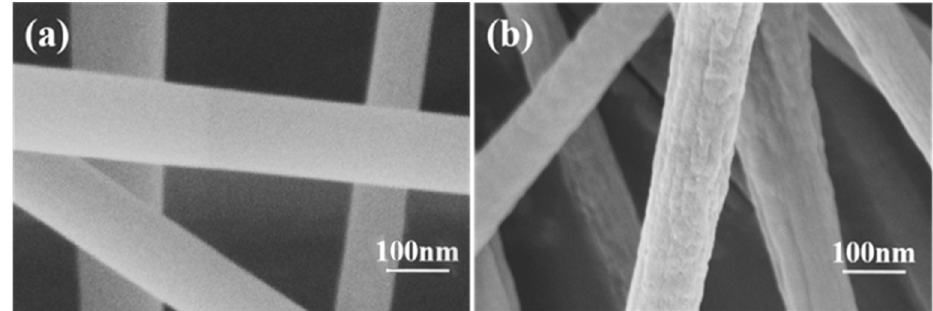
Figure 1. SEM images of ( a ) C − 0 nanofiber and ( b ) C − 1 nanofiber. The SEM images of carbon nanofibers (C − 0, C − 0.25, C − 0.5, C − 1, and C − 1.5)